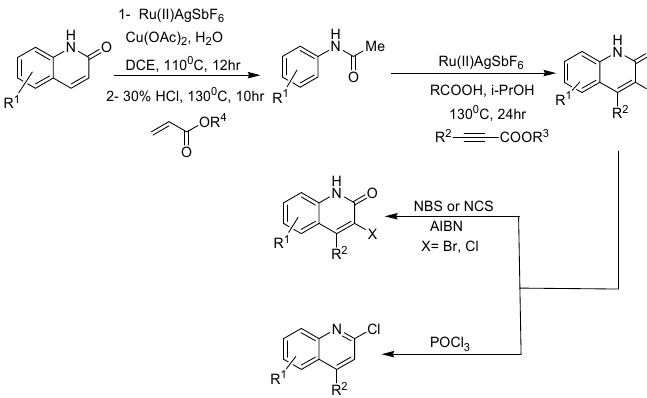
Scheme 8. Synthesis of 2-quinolones through ruthenium catalyzed cyclization of anilides with substituted propiolates or acrylates [28].